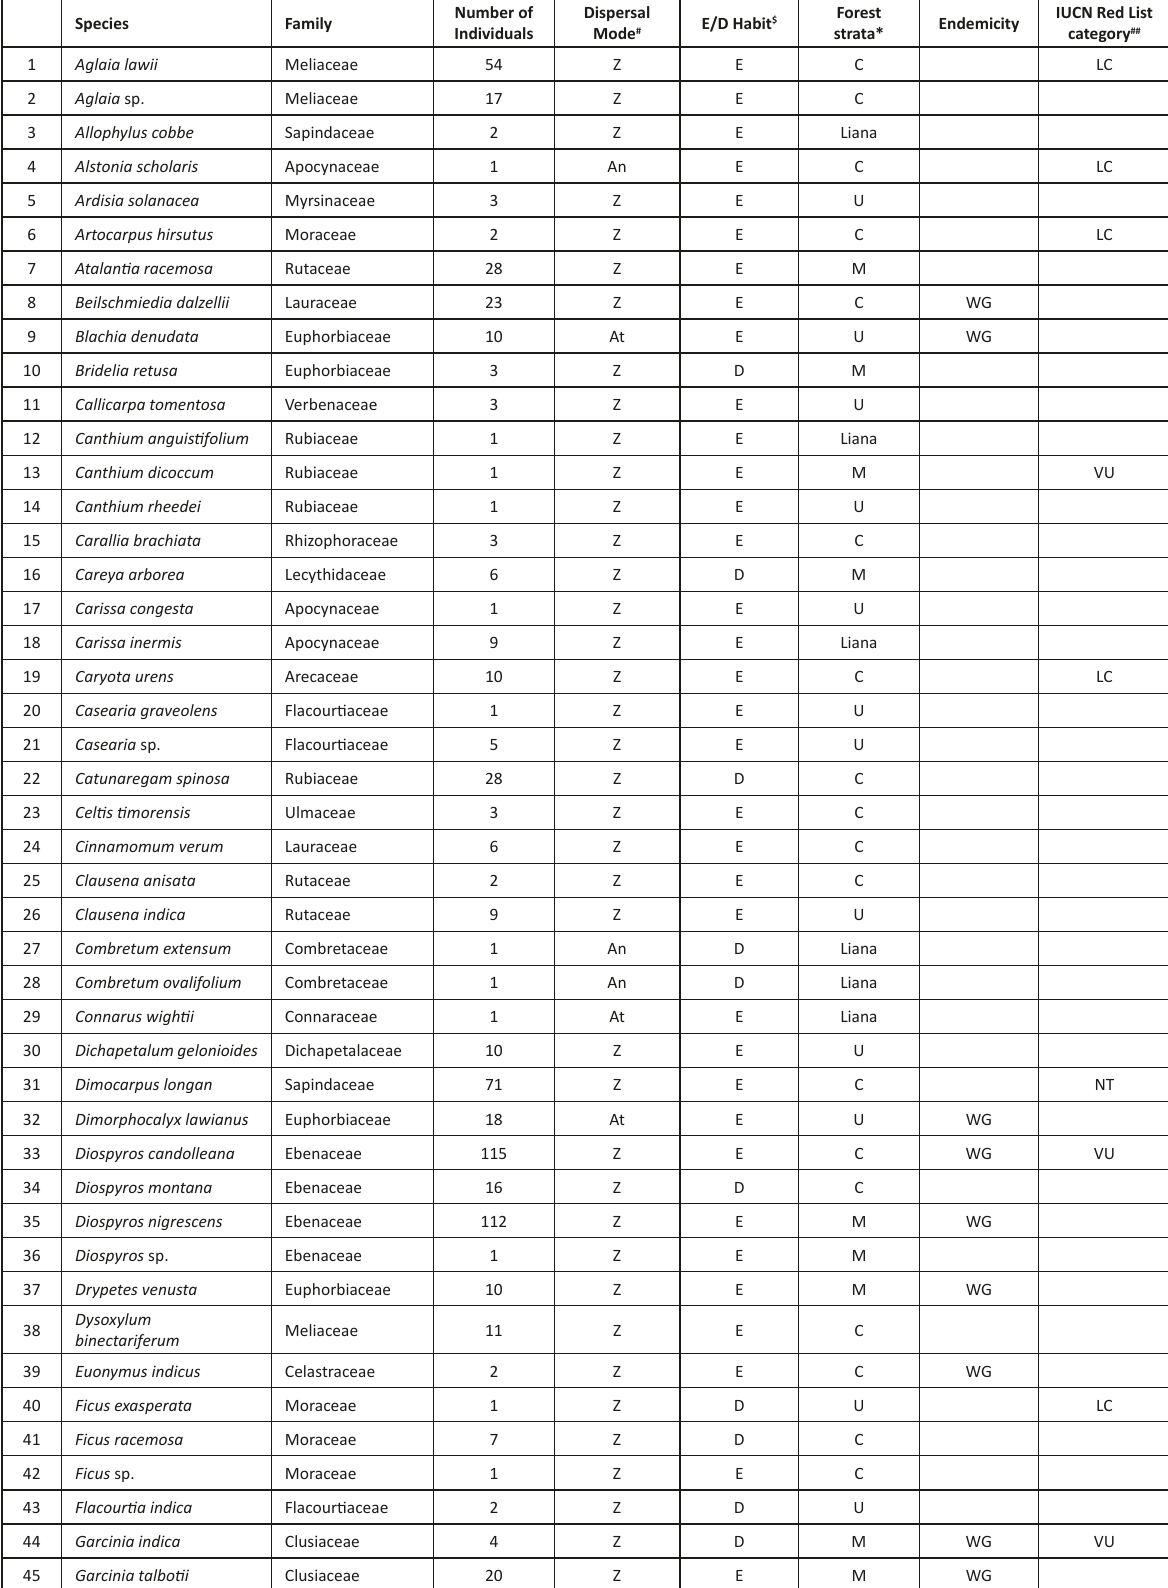
Table 2. Species encountered in the sampled plots and their attributes.